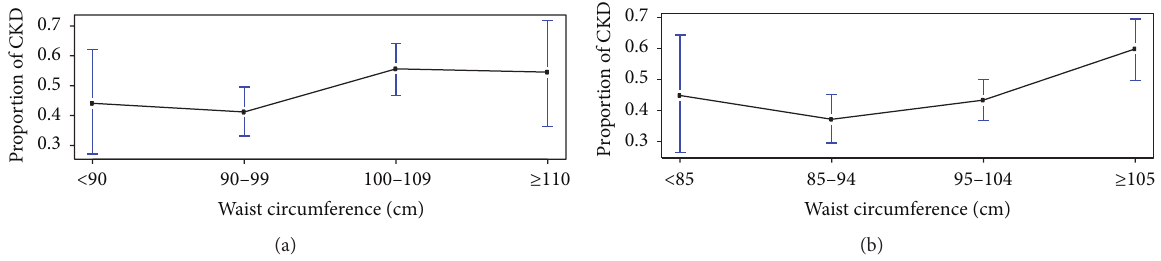
Figure 1: Proportion of chronic kidney disease among type 2 diabetes patients with different waist circumferences. (a) Proportion of CKD among male T2D patients. (b) Proportion of CKD among female T2D patients. CKD: chronic kidney disease; T2D: type 2 diabetes; WC: waist circumference.